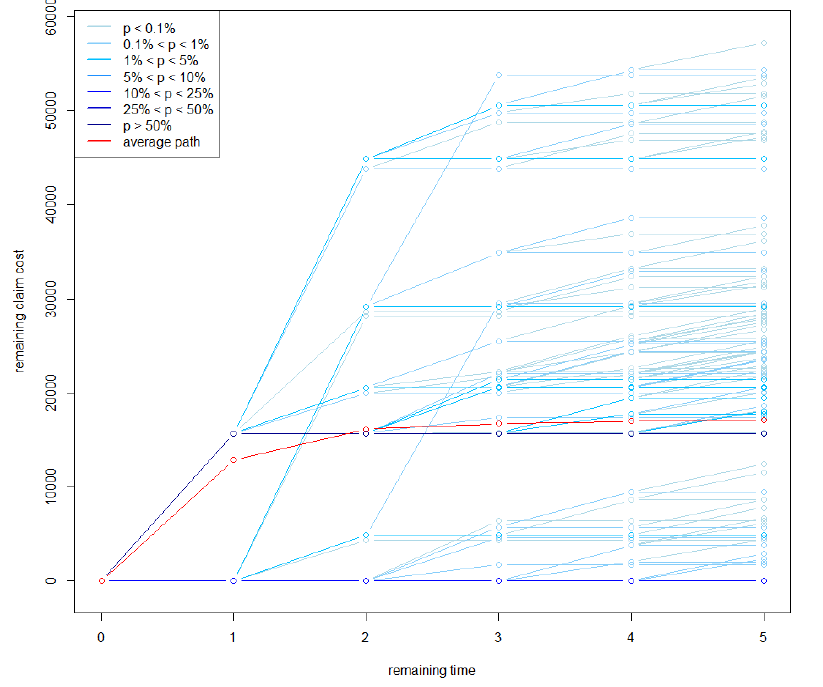
Figure 4. Representation of N = 5000 simulated paths for the type-1 cost development of the chosen ( ν ) claim C . In red the average path is 6,0